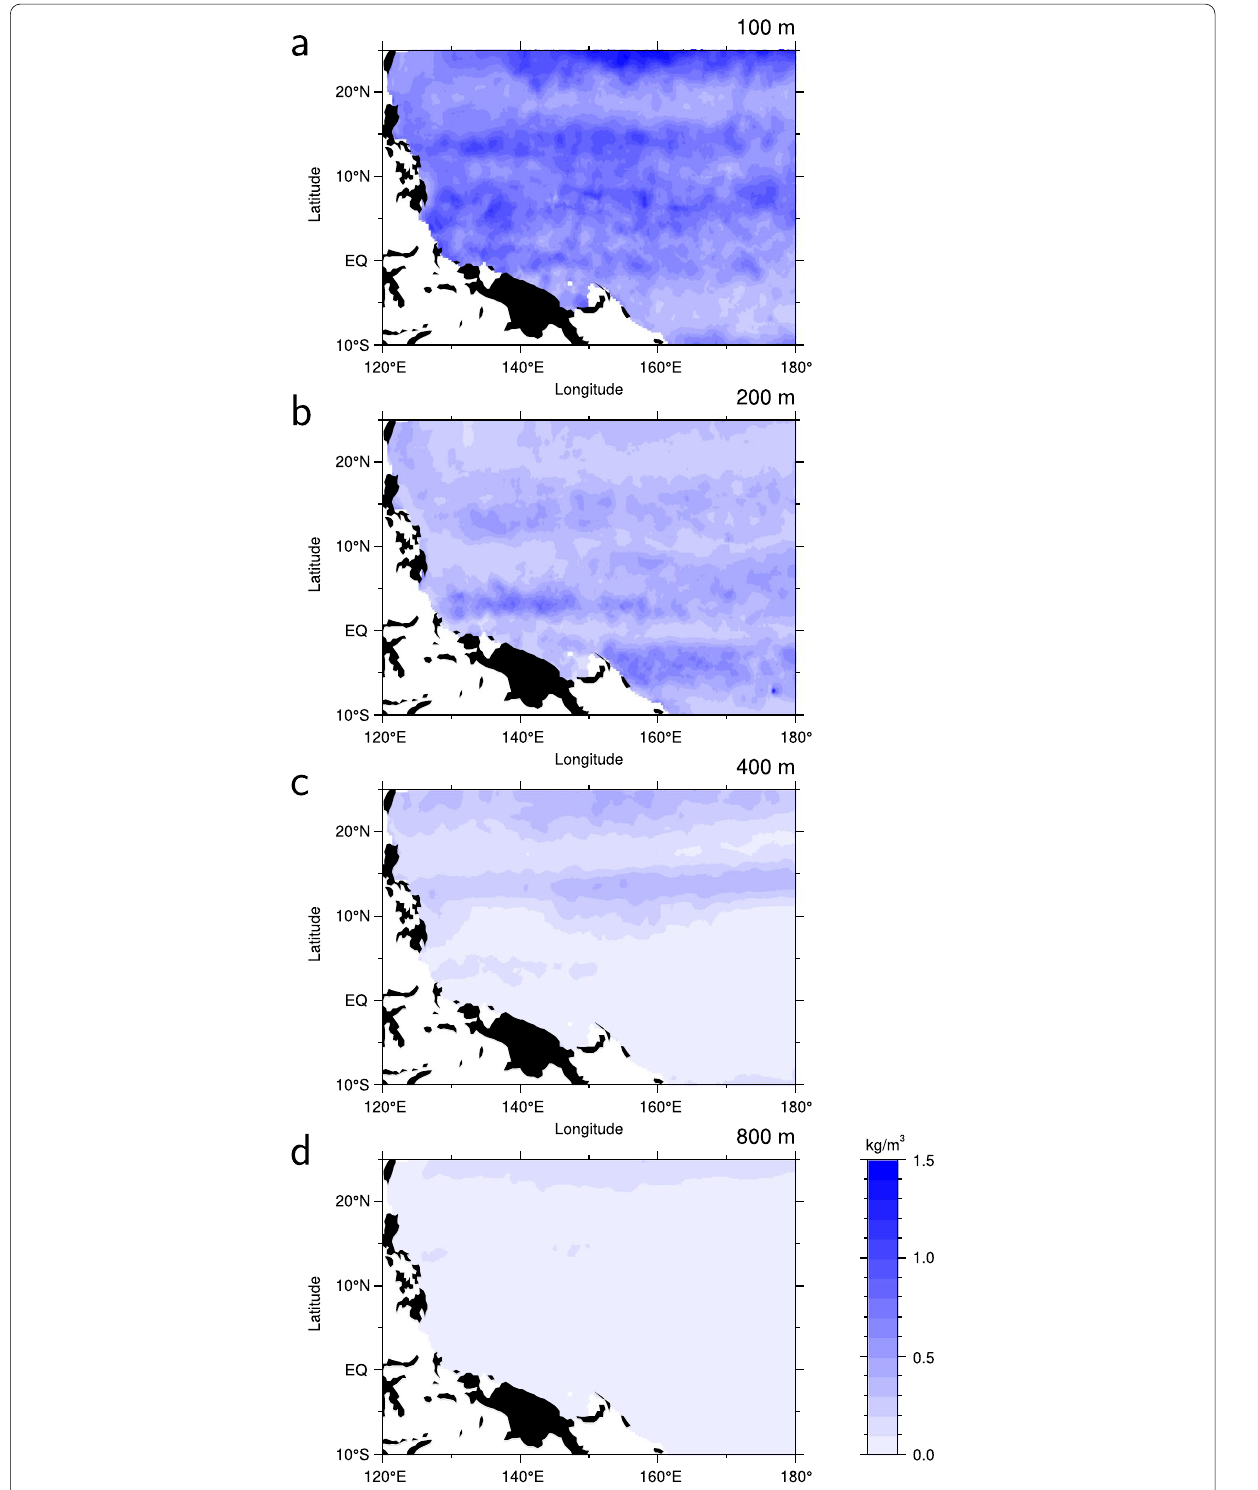
Fig. 4 Root-mean-square difference between AGEM-derived and Argo-observed potential density at depths of a 100, b 200, c 400, and d 800